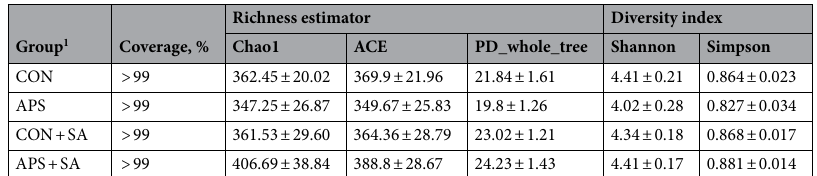
Table 2. Alpha diversity indices of the cecal microbiota of broilers. 1 CON: control pair-fed group; APS: APS-supplemented pair-fed group; CON + SA: control S. ser. Enteritidis -challenged group; APS + SA: APS- supplemented S. ser. Enteritidis -challenged group.